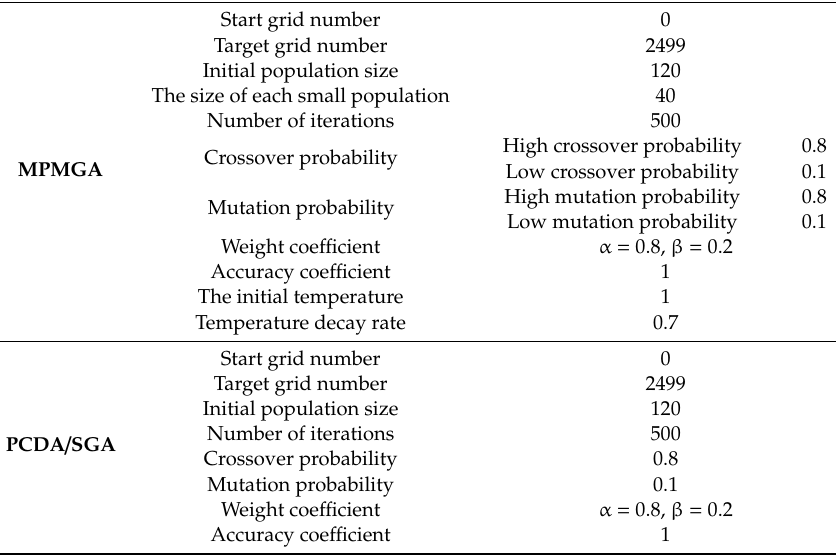
Table 5. Algorithm Table 5. Algorithm parameters.